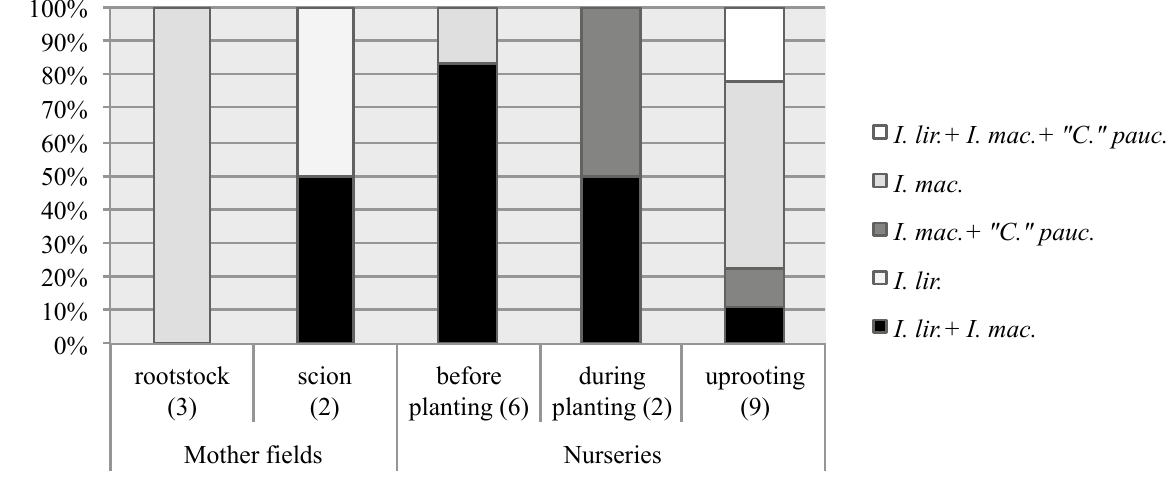
Figure 2. Proportion of Ilyonectria liriodendri ( I. lir.) , I. macrodidyma complex ( I. mac .) and “ Cylindrocarpon ” pauciseptatum (“ C.” pauc .), alone or in combination, in the different soils sampled, assessed by multiplex nested PCR (sample size in